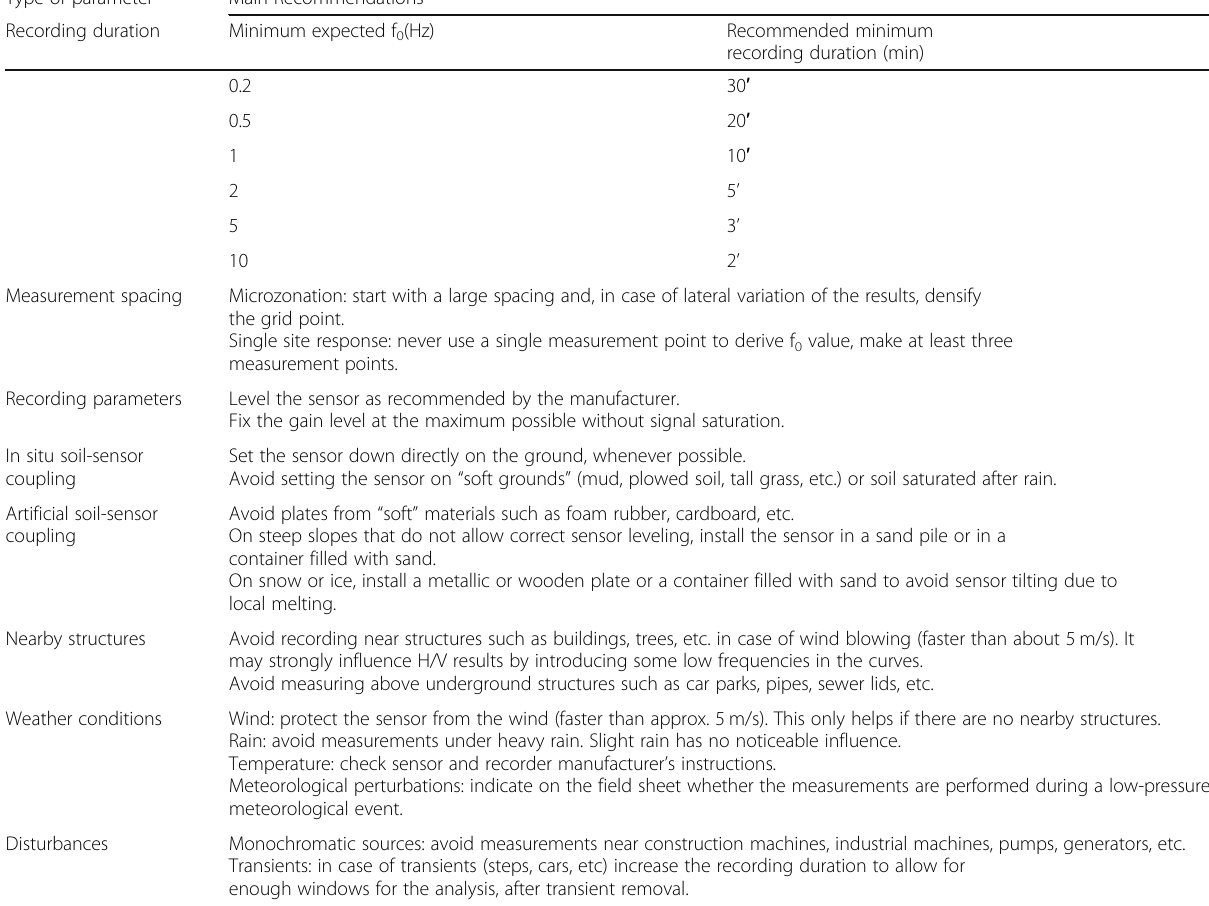
Table 1 A summary of recommendations from SESAME guidelines (Bard and the WG 2004) Type of